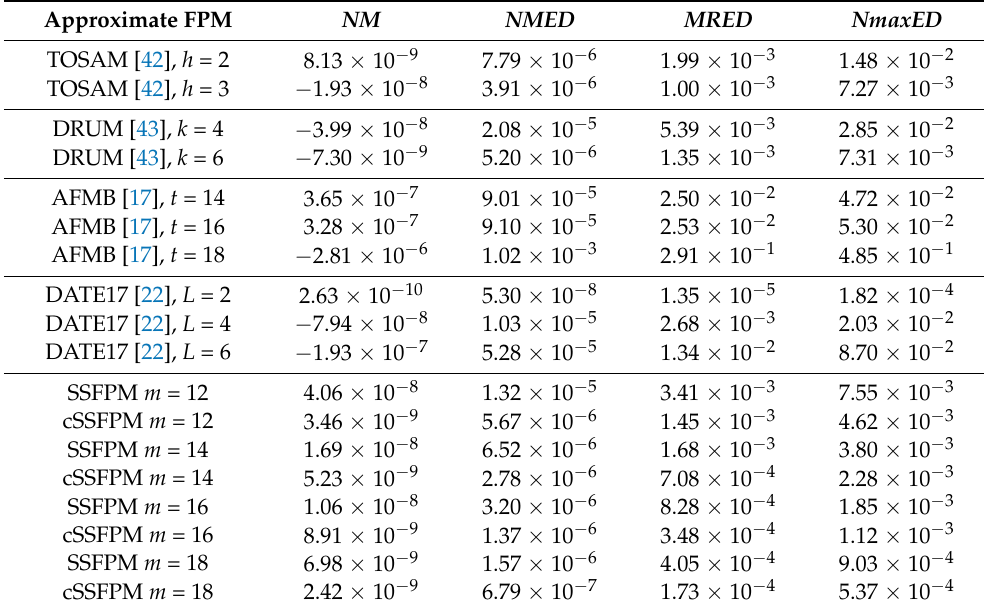
Table 2. Error metrics of the approximate